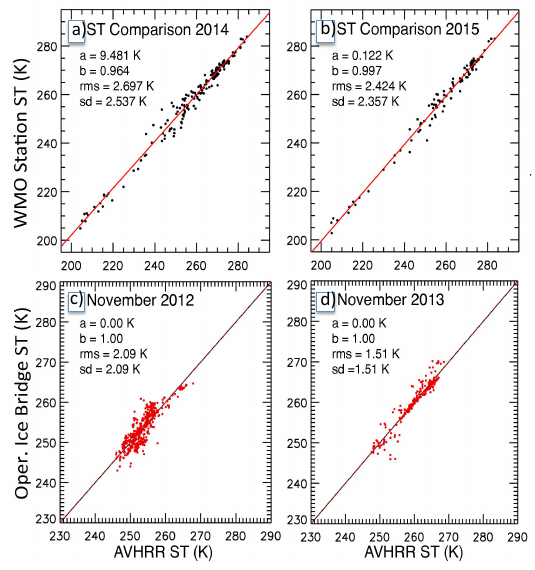
Figure 5. Scatter plot of in situ (WMO) surface temperature data versus AVHRR data in (a) 2014 and (b) 2015. Scatter plot of aircraft operation ice bridge surface temperature data with AVHRR data in (c) November 2012 and (d) November 2013.